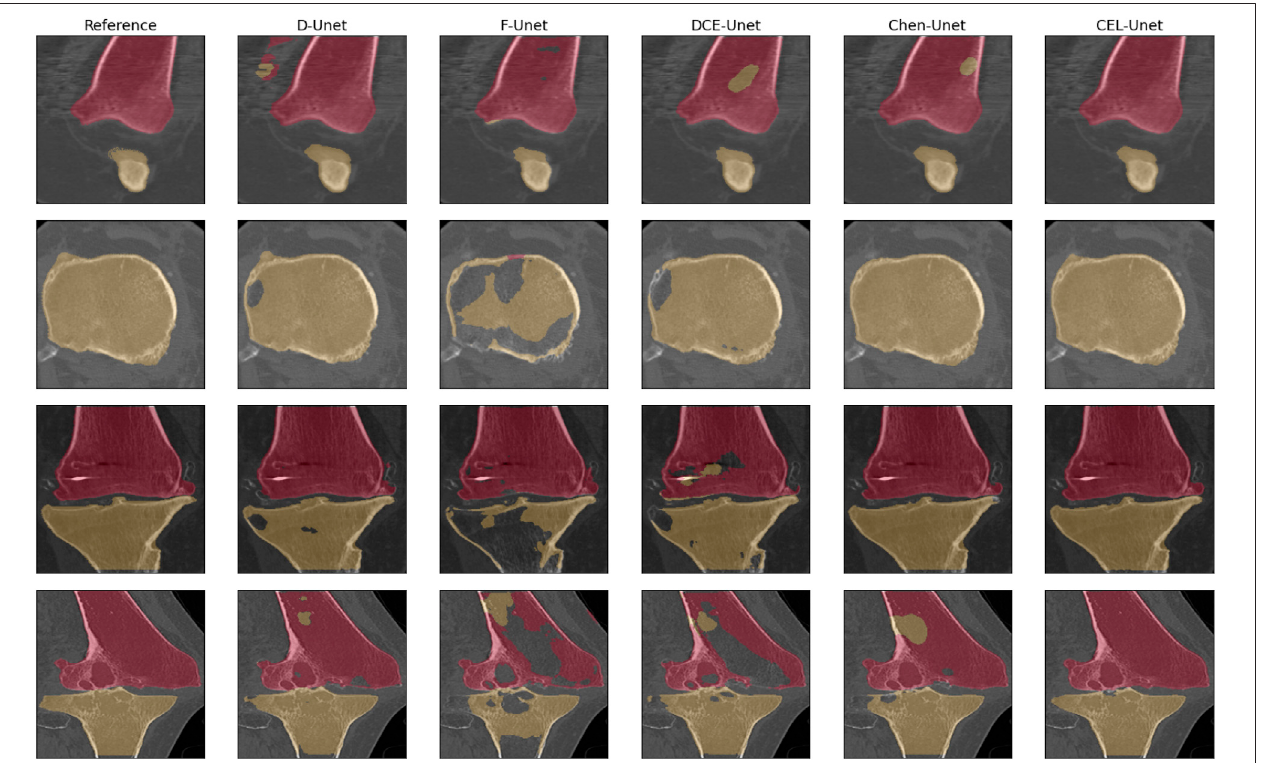
FIGURE7| Qualitativecomparisonofthesegmentation offemur(purple)andtibia(lightbrown)in4criticalcases(case#176coronalslice:44;case#11,axialslice: 62; case #11, coronal slice 78; case #194, coronal slice 82).